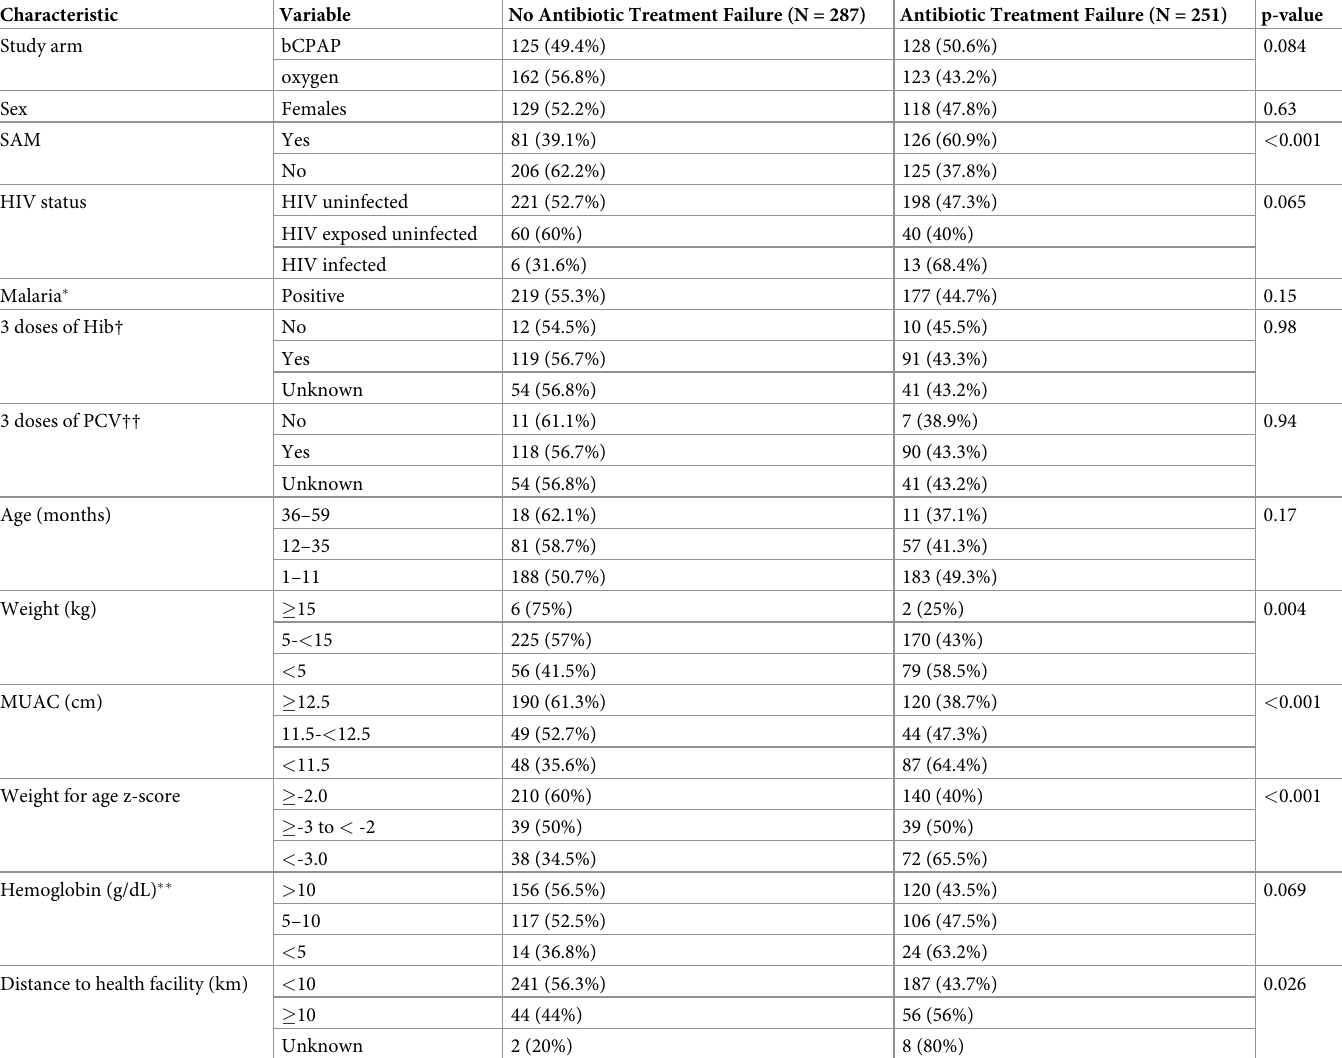
Table 2. Baseline participant characteristics by antibiotic treatment failure outcome.